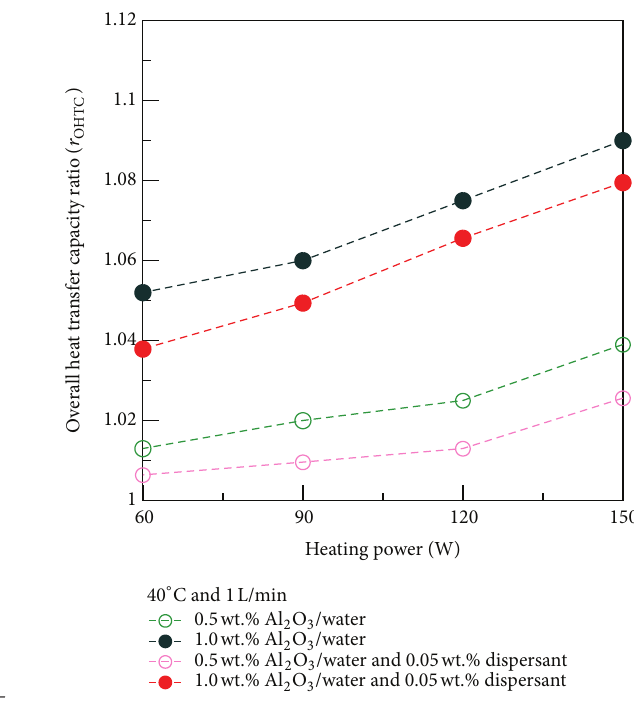
Figure 5: Correlations between temperature and thermal conduc- tivity.